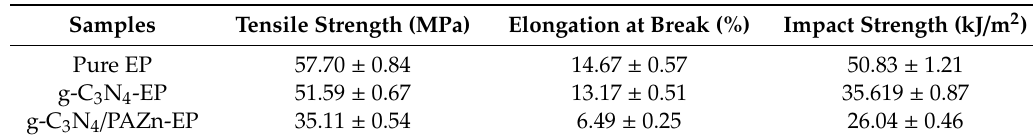
Table 4. Mechanical properties of EP composites.